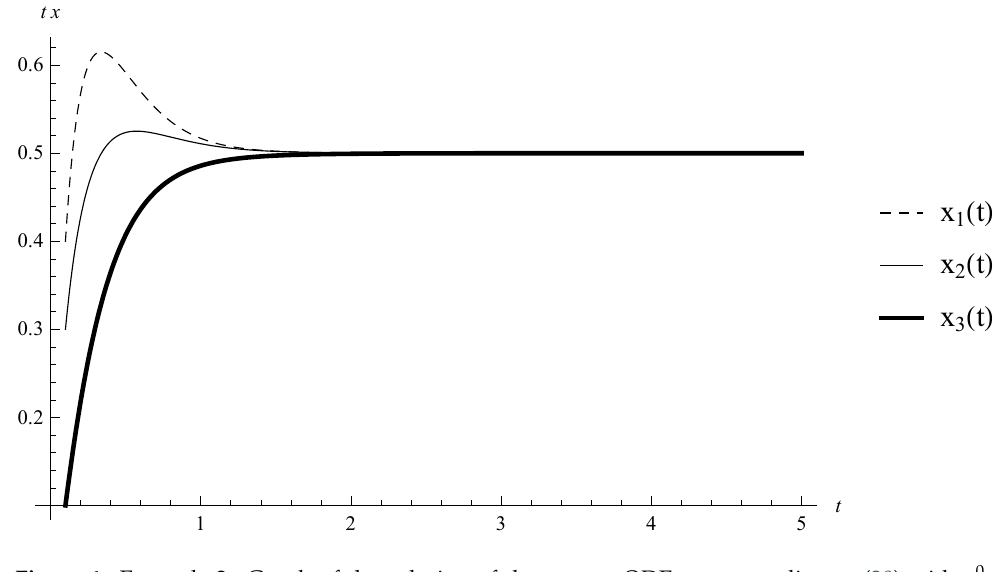
Figure 4. Example 2. Graph of the solution of the system ODE corresponding to (20) with x 0 = 0.3, x 0 = 0.4, x 0 2 3